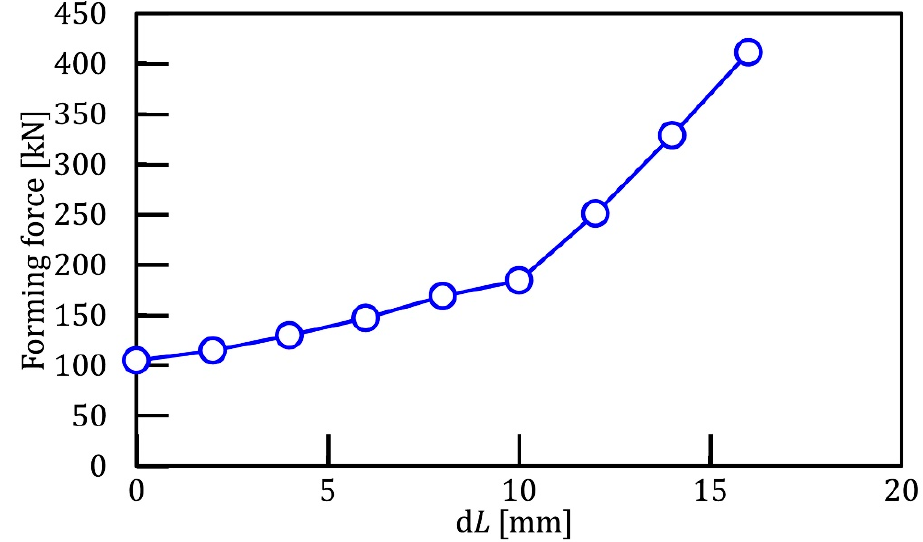
Figure 8. Forming force in hot hat-shaped bending using compression in-plane direction. The variations in temperature at the top and flange corners and the middle of the sidewall without and with partial cooling are illustrated in Figure 9. The temperature was measured by k-type thermocouples with a diameter of 0.32 mm, which were welded to the specimen using spot welding. Although the decrease in temperature of the sidewall without partial cooling is slow, the temperature of the sidewall is rapidly dropped by partial cooling, and thus thickening of the sidewall is prevented by hardening as shown in Figure 7.